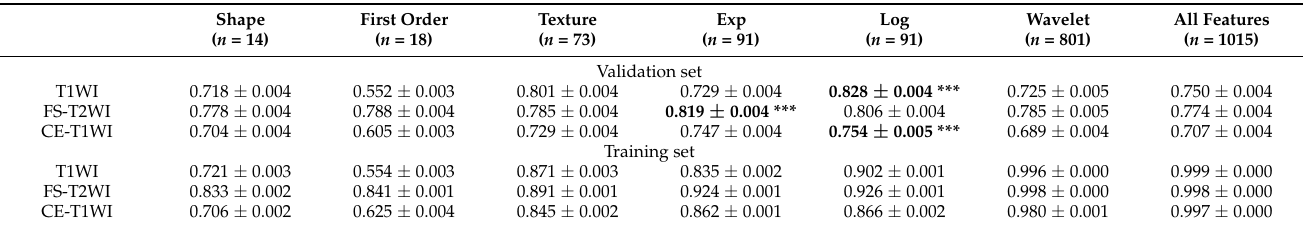
Table 2. The performance (AUC) of MRI sequence and feature category for discriminating MSGTs from